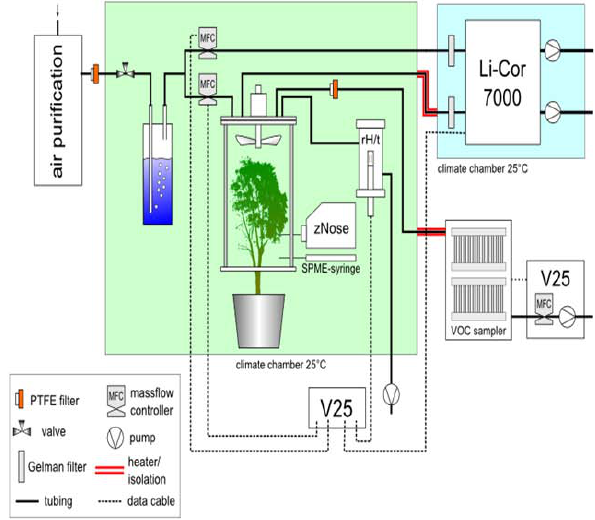
Fig. 2. Overview of the cuvette system. The SPME and zNose are attached to the cuvette system by simply puncturing the Teflon foil with their respective